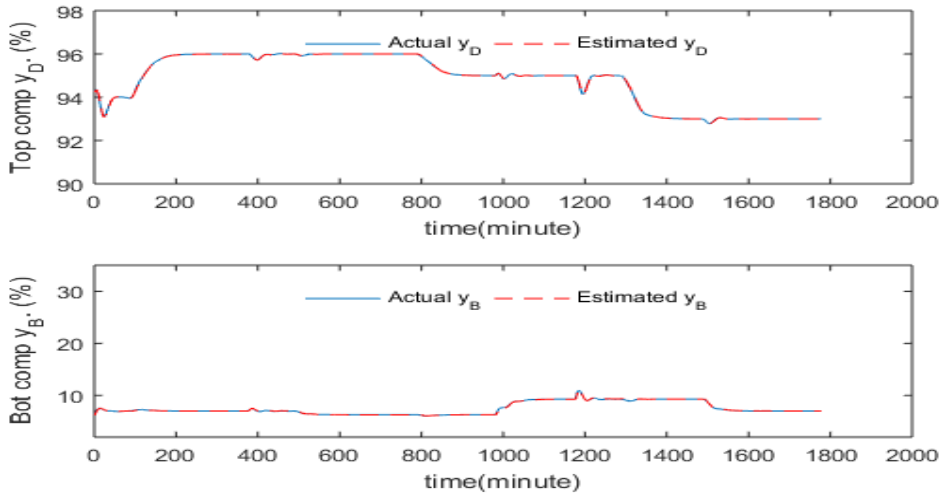
Figure 7. Model predictions from the 5th order dynamic PCR model.